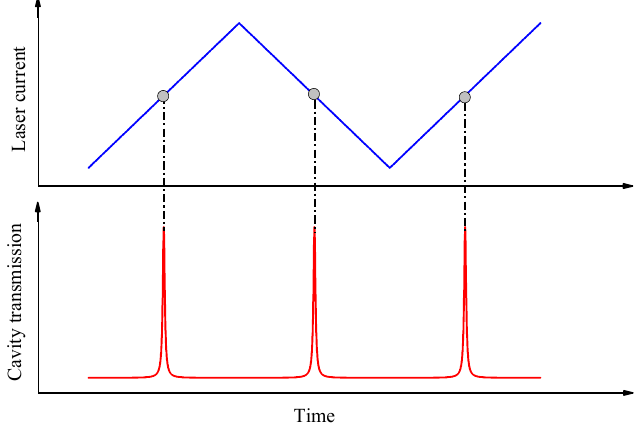
Figure 2. Mode matching the laser wavelength to the resonance of an optical cavity by feedback controlling the laser operation current so that the resonance occurs in the middle region of a small dithering of laser current.